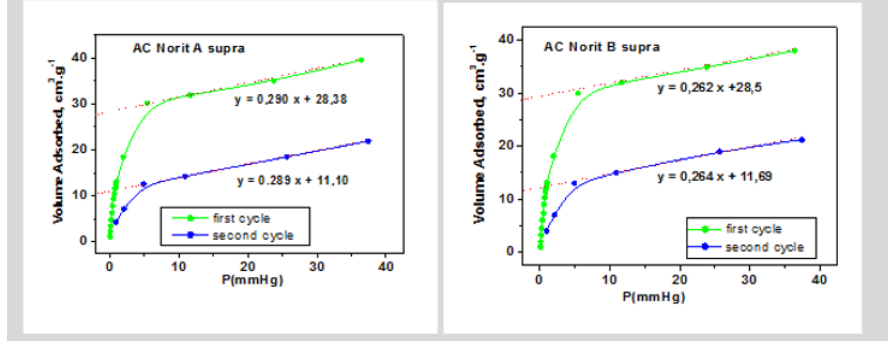
Fig. 3. Profile of two cycles of adsorption of ammonia on Norit A SUPRA EUR and Norit B SUPRA EUR at T = 303